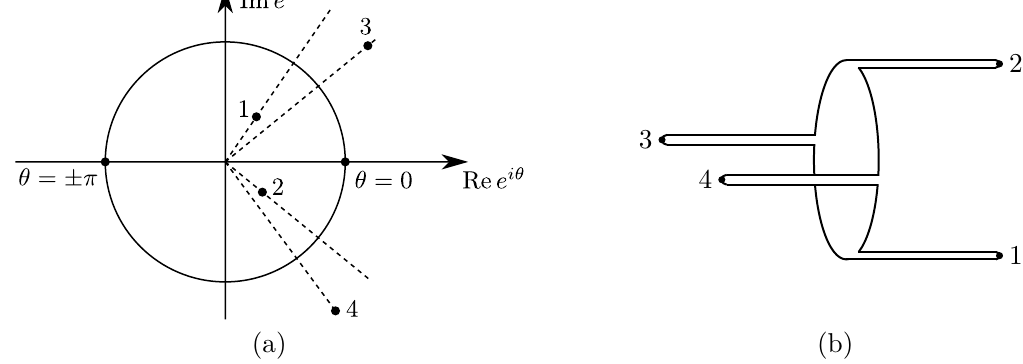
Figure 1. (a) The complex times θ 1 , θ 2 , θ 3 , θ 4 in terms of the variable e iθ = e − t e iτ . (b) A symmetric case, where the points 1,2,3,4 are placed on a cylinder with the axial coordinate t (going left to right) and connected by a contour such that the contour ordering coincides with the τ